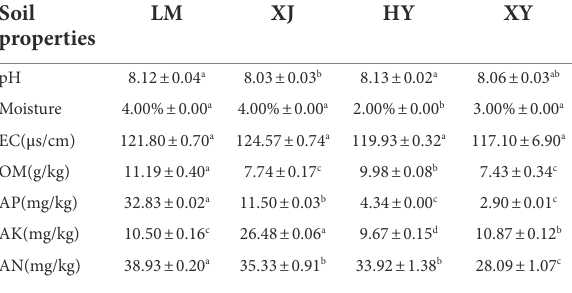
TABLE 1 Soil properties in the rhizosphere of four Populus